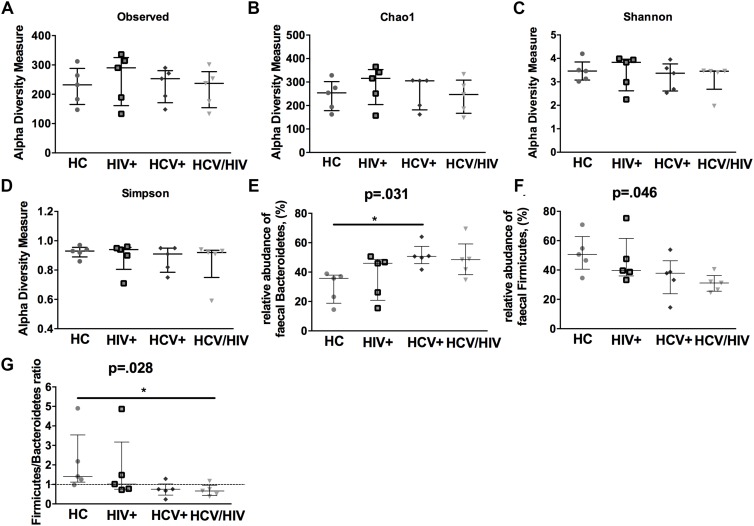
Alpha-diversity indexes and fecal bacteria relative abundance. The lines indicate the significant comparison between two groups. ∗ indicates the p-value for each pair of groups: ∗
p < 0.05, ∗∗
p < 0.01, ∗∗∗
p < 0.001. We calculated (A,B) richness (observed and Chao1) and evenness (C,D) (Shannon and Simpson) indexes, failing to find any differences among the study groups. (E) higher relative abundance of Bacteroidetes (p = 0.031), (F) lower relative abundance of Firmicutes
(G) and lower Firmicutes/Bacteroidetes ratio (p = 0.028).